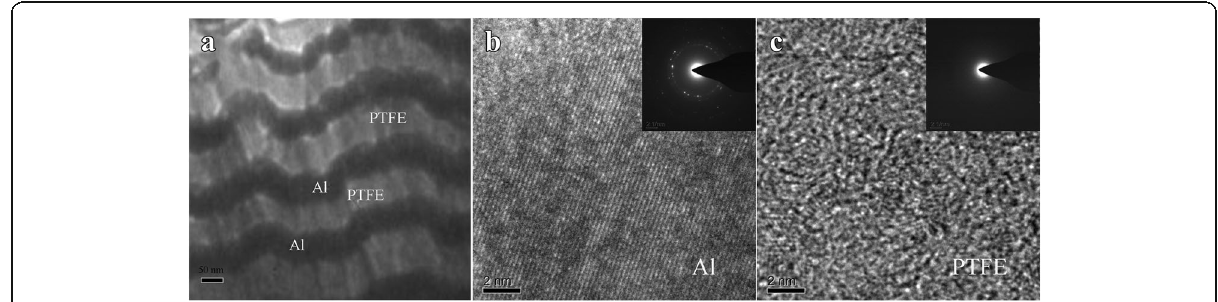
Fig. 2 a Cross-sectional bright-field TEM image of the Al/PTFE nanolaminates. b High-resolution image of the Al layer and the electron diffraction pattern is inserted. c High-resolution image of the PTFE layer and the electron diffraction pattern is